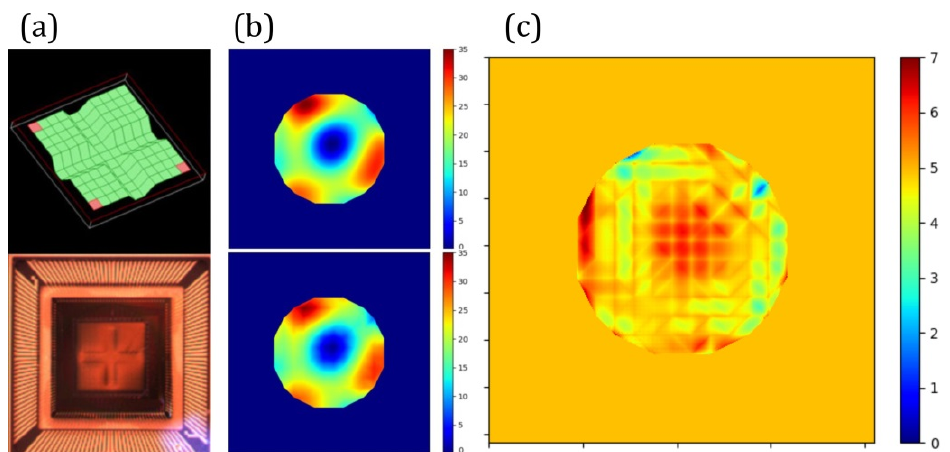
Figure 4. MEMS mirror modeling. ( a ) Mirror segments (according to the documentation from the manufacturer’s website); ( b ) initial phase and phase of the mirror obtained by simulation; ( c ) the difference between the phases from Figure ( b ). Color bars are in radians.